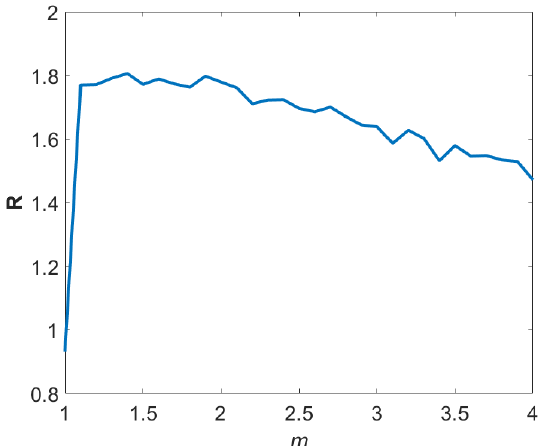
Figure 2. The plot showing variation of R as the value of m increases for a rectangular window function.